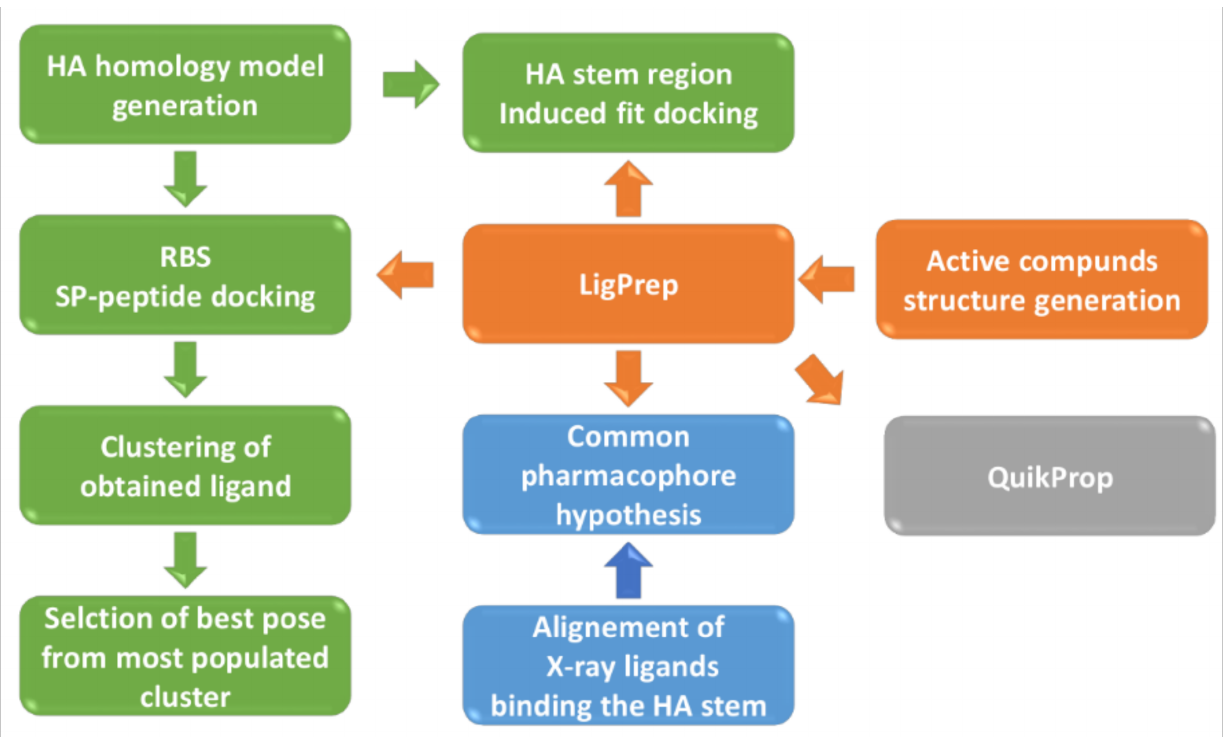
Figure 3. Schema reporting the step-by-step procedure applied in the computational